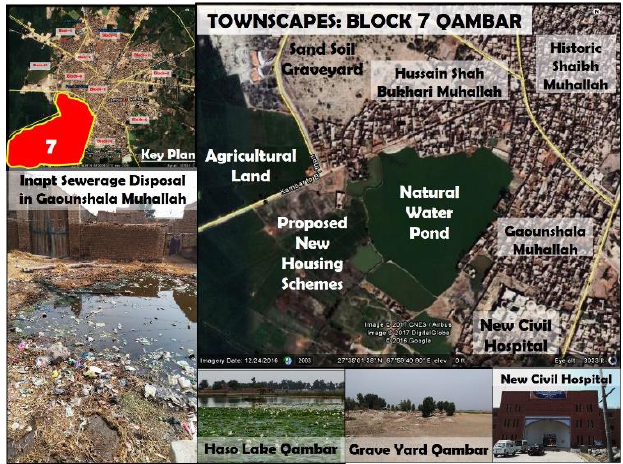
Fig. 11 . Townscape’s analysis of Qambar: serial vision and experiential quality of city within urban block 7